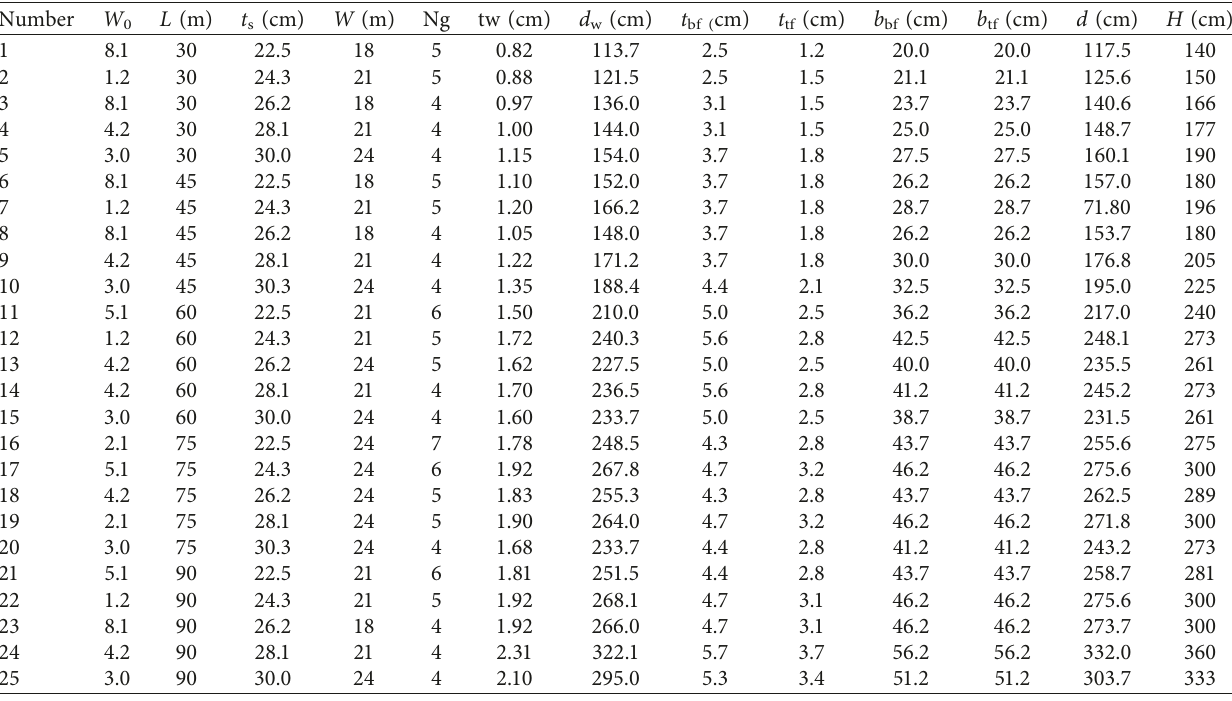
Figure 1: Cross-sectional view of a typical composite slab-on-girder bridge. Table 2: Characteristics of the composite slab-on-girder bridges modeled in the study.